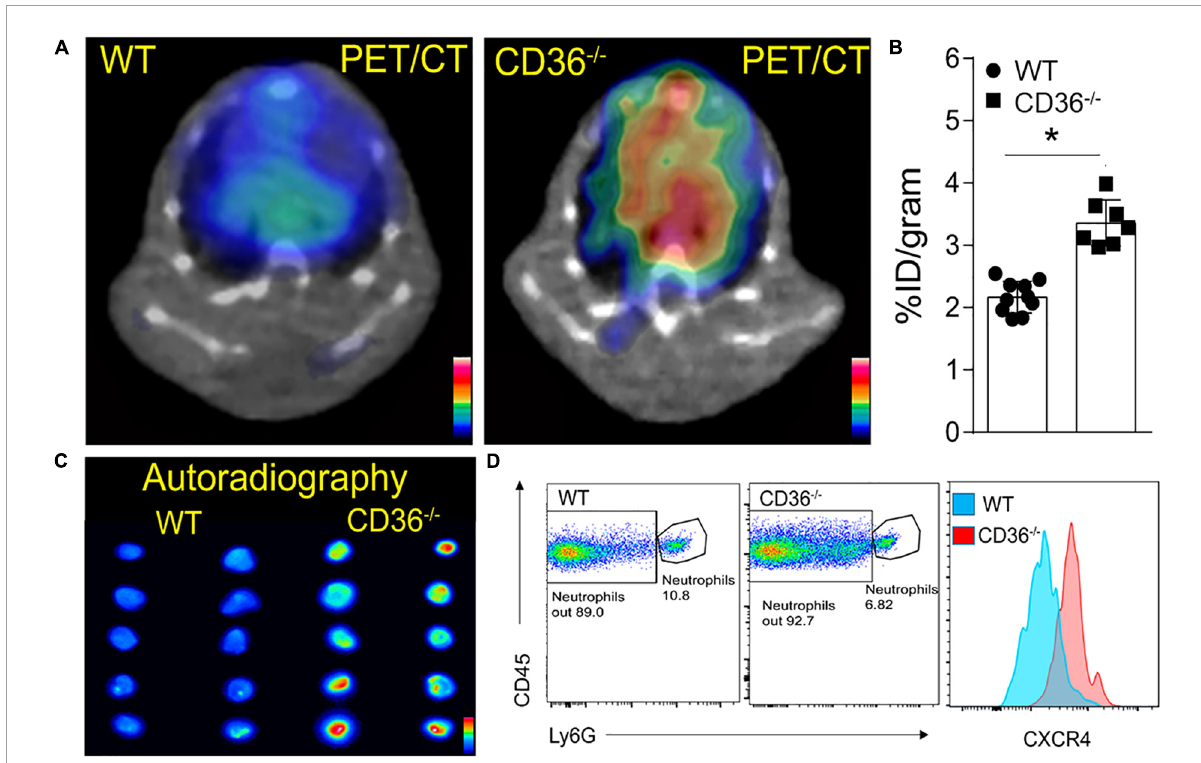
FIGURE5 Visualization of activated neutrophils in the heart of wild type (WT) and CD36 null (CD36 − / − ) mice. (A) Neutrophils are visualized non-invasively using 64 Cu-AMD3100 tracer and PET/CT scanning. (B) Quantification of 64 Cu-AMD3100 tracer in the heart ( n = 10 in WT mice, n = 7 in CD36 − / − mice). (C) Ex vivo autoradiography of heart slices collected from WT and CD36 − / − mice immediately after the PET scan to further document uptake of 64 Cu-AMD3100 ( n = 2/group). (D) Flow cytometric analysis of CXCR4 expression on cardiac neutrophils isolated from WT and CD36 − / − mice ( n = 3/group). All data are means ± SE with n representing the number of mice per group. Statistical significance is determined by the unpaired non-parametric Mann–Whitney t -test. * p < 0.05.